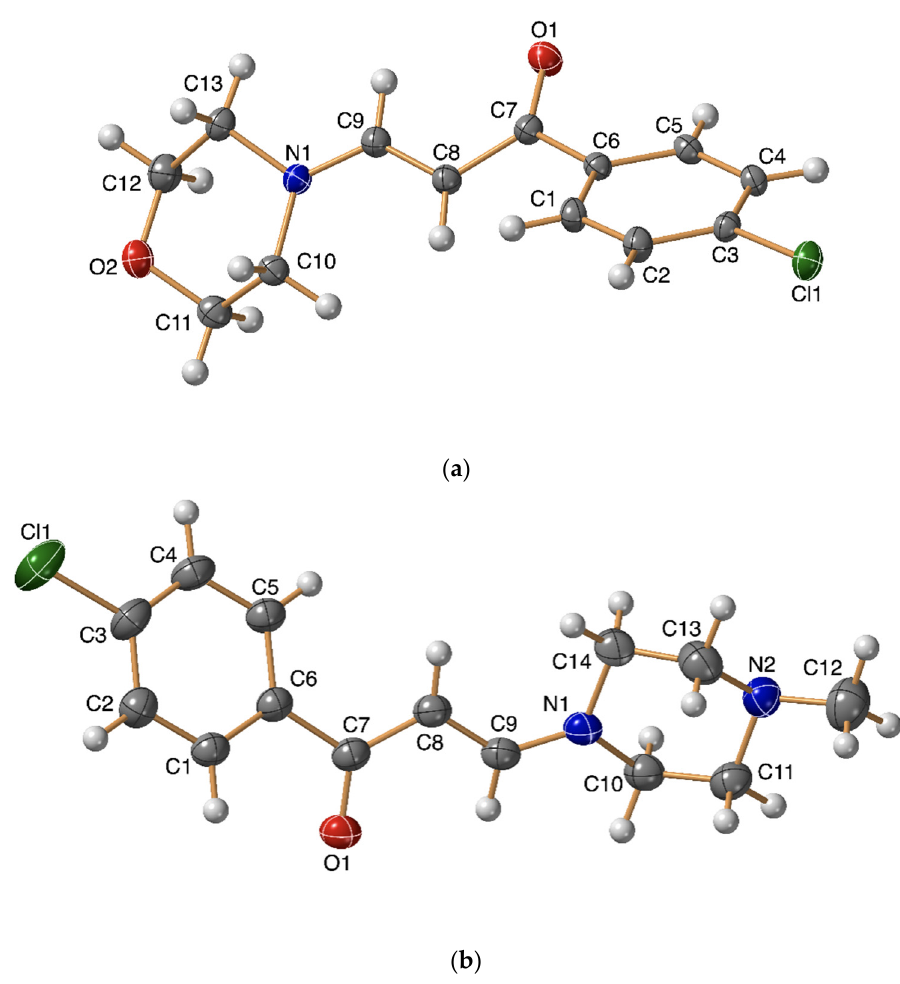
Figure 1. X-ray structure of 1 ( a ), and 2 ( b ). Thermal ellipsoids were drawn at 50% probability level. Table 1. Selected bond lengths [Å] and angles [°] for 1 .